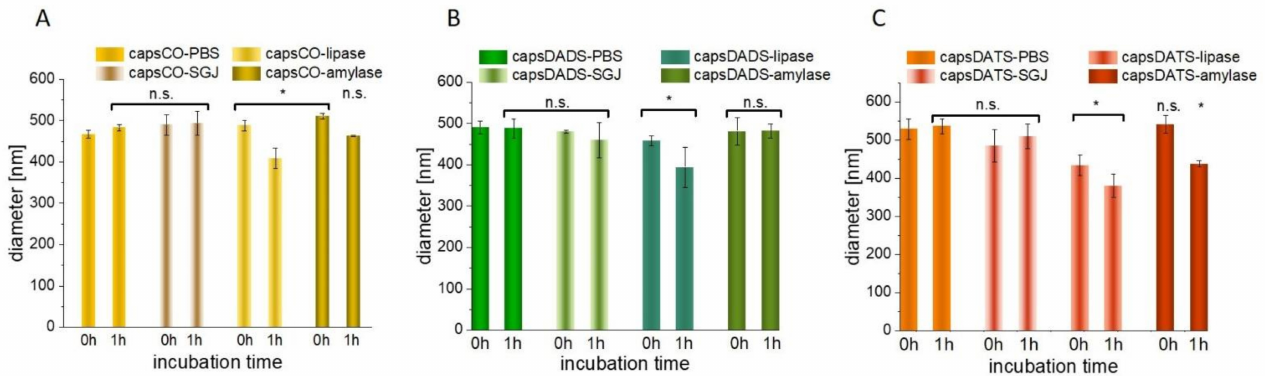
Figure 6. Interaction of capsCO ( A ), capsDADS ( B ) and capsDATS ( C ) with a simulated gastric juice (SGJ), lipase and amylase solution. The data shown as mean +/ − SD, (n = 4) represents the diameters of capsules in freshly prepared samples and after 1 h incubation at 37 ◦ C. Significance estimated with the Mann-Whitney U-test in relation to the respective control groups; * p < 0.05; n.s.—not